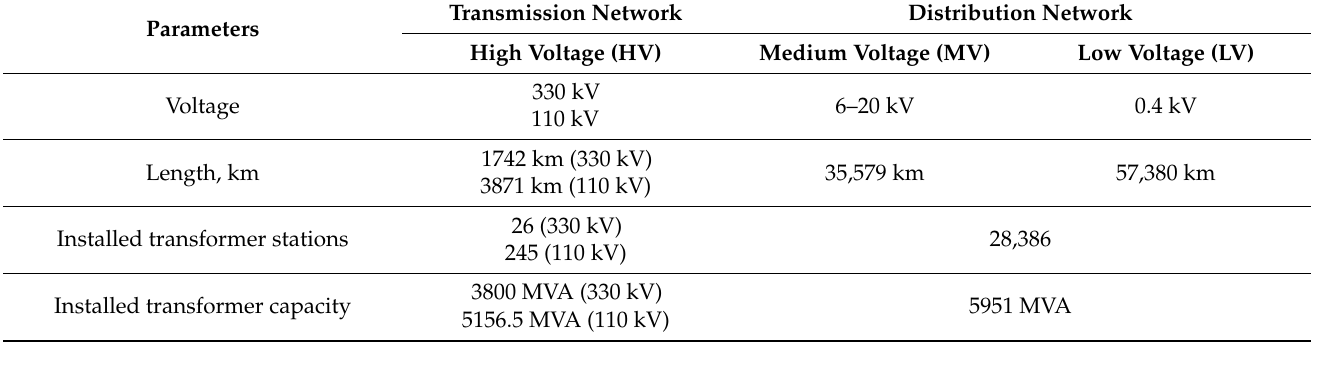
Figure 3. Electric power system.